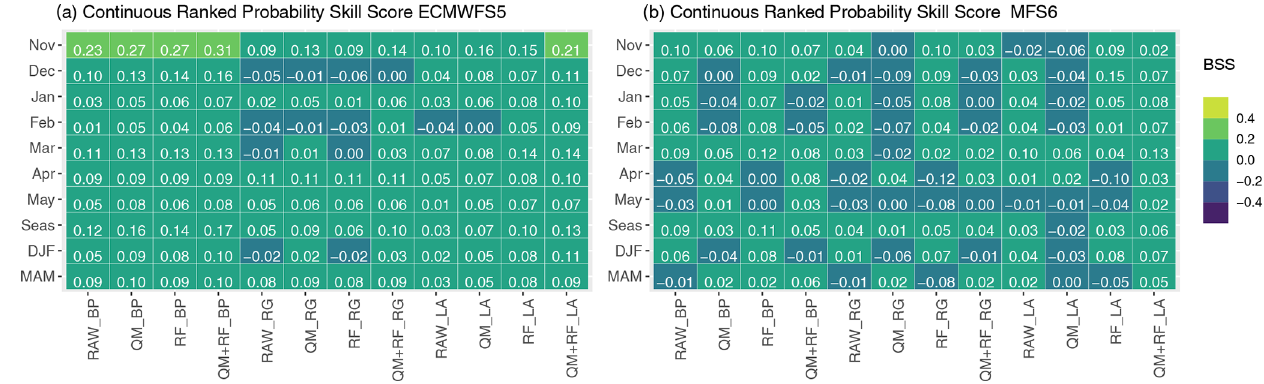
Figure 12. CRPSS of the detrended monthly and seasonal (DJF, MAM) snow depth forecasts with respect to the climatological forecasts, using observations at the three stations as a reference, for (a) ECMWFS5 and (b) MFS6 systems. Positive and negative CRPSS are highlighted in shades of green and blue,